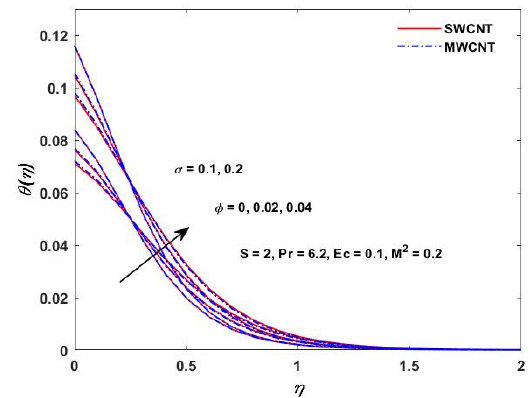
Figure 10. 𝜎 verses 𝜃(𝜂). Figure 10. σ verses θ ( η )